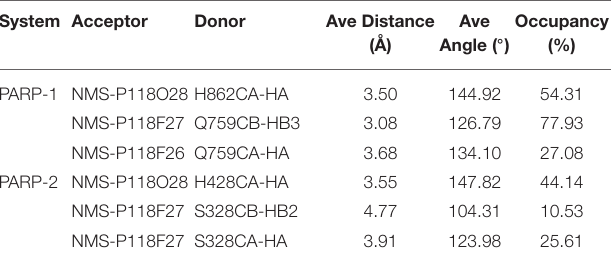
( Table 3 ). The binding free energy of E763 is 0.95 kcal/mol TABLE 3 | Occupancy of hydrogen bonds between Q759/S328 and the ligand during MD